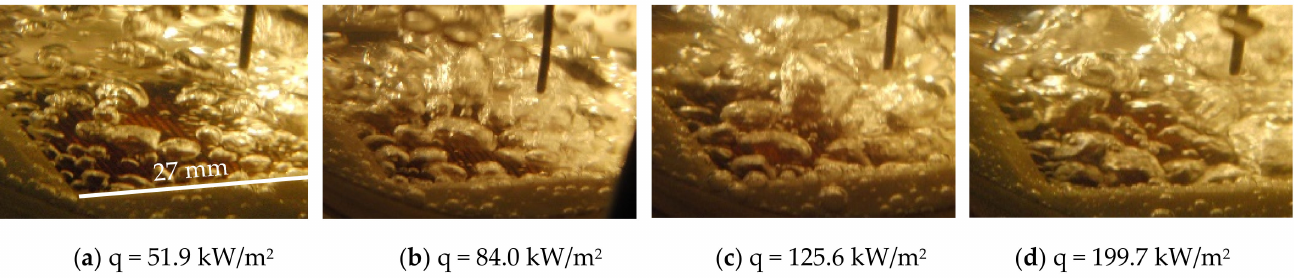
Figure 12. Visualization observation of pool boiling of water on the entire area of the surface with microchannels (MC-0.4-